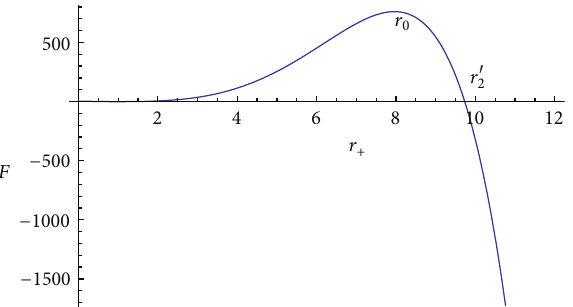
Figure 12: Plot of free energy ( F ) against horizon radius ( 𝑟 + ), for 𝛼 󸀠 = 0.50 , 𝑄 = 0.50 , and 𝑏 = 10 .